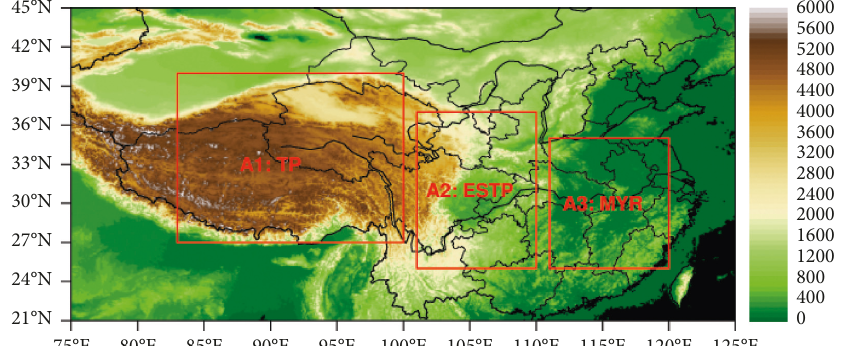
Figure 1: The location of the three key regions along the eastward-moving path (A1 represents the Tibetan Plateau (TP) region, A2 represents the eastern slope of Tibetan Plateau and its peripheral region (ESTP), and A3 represents the middle and lower reaches of the Yangtze River region (MYR)).